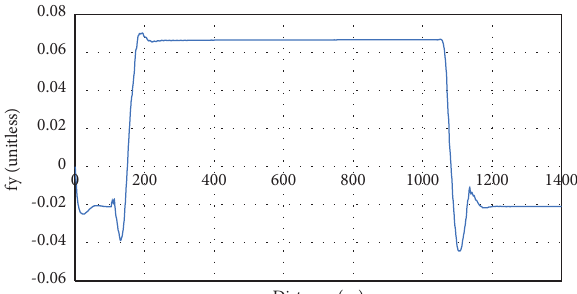
Figure 12: Side friction factor in simple horizontal curves along the path of a truck.